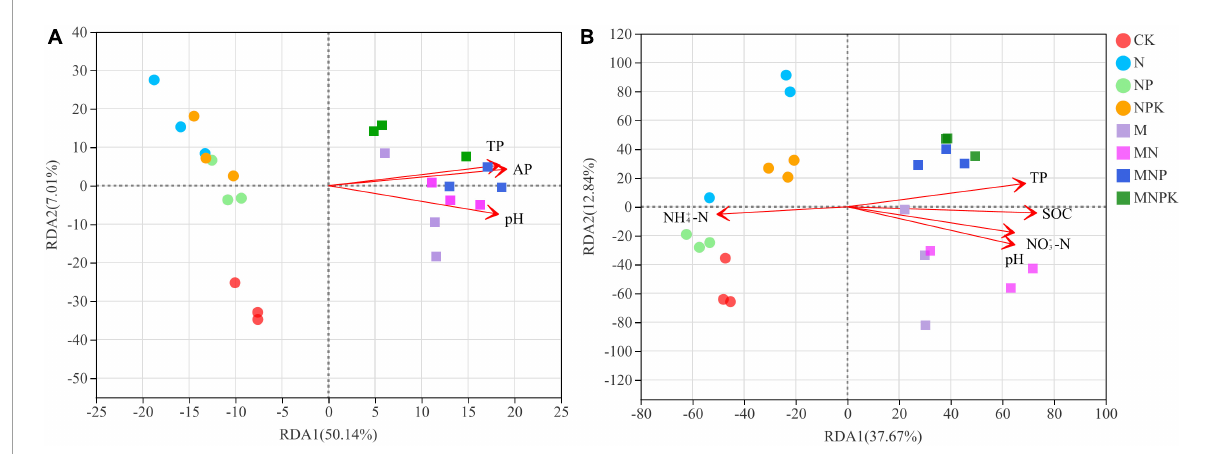
FIGURE4 Redundancy analysis (RDA) of the relationship between microbial communities and the soil properties. (A) Bacterial community, (B) fungal community. SOC, soil organic carbon; TP, total phosphorus; NH 4 + -N, ammonium nitrogen; NO 3 − -N, nitrate nitrogen; AP, available phosphorus.